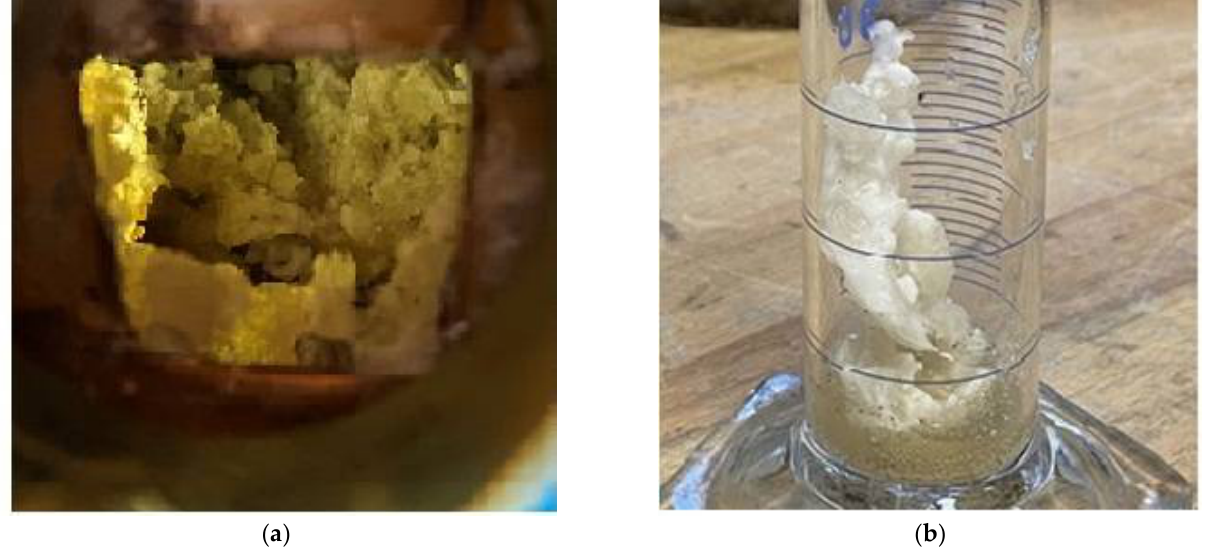
Figure 7. ( a ) Natural gas hydrate formed in an experimental device, scale 2:1; ( b ) Sample of hydrate taken in a volumetric cylinder, scale 2:1.